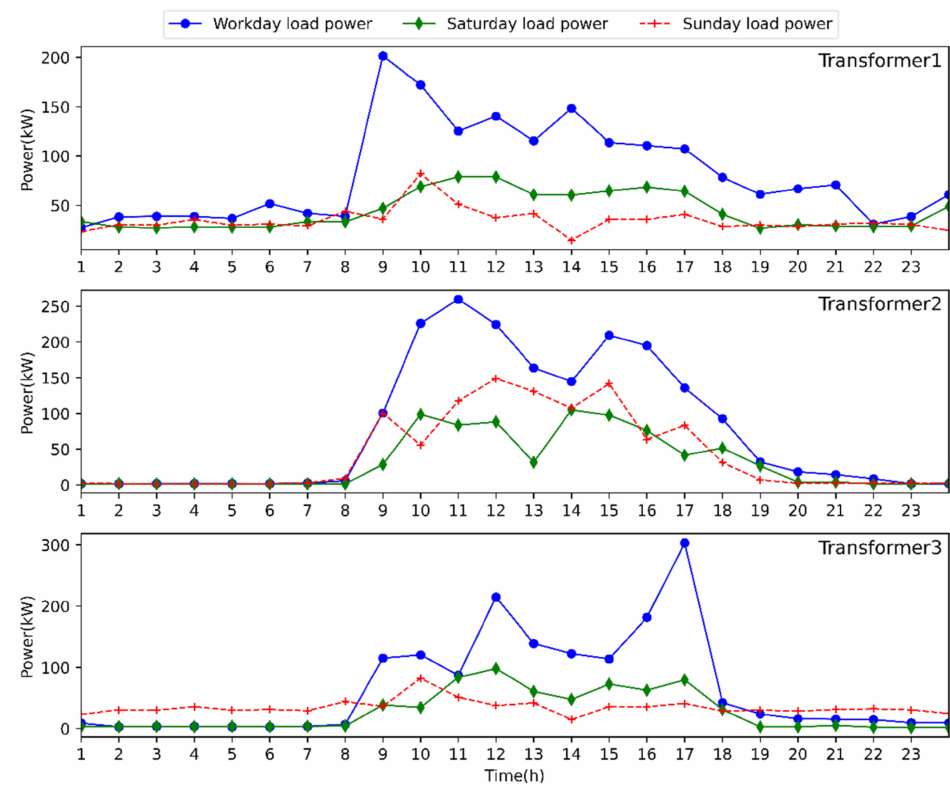
Figure 5. Typical load curves under different